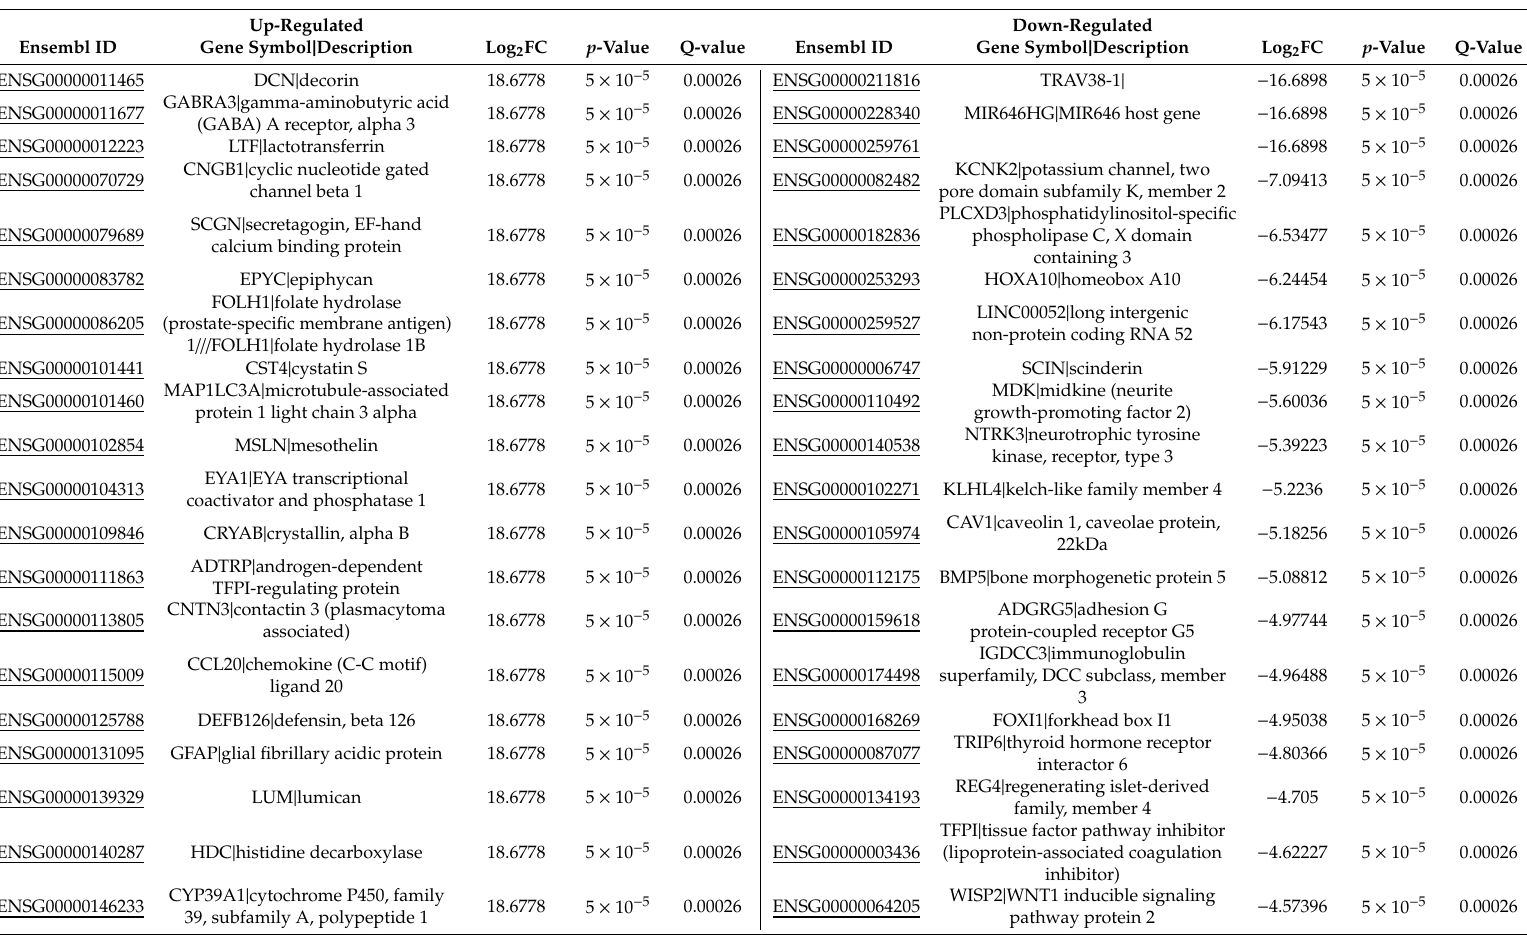
Table 1. Top 20 up-regulated and down-regulated genes between MCF7 / pS and MCF7 / pR ranked by p -value (pval ≤ 0.05; qval ≤ 0.05; | log 2 FC | ≥